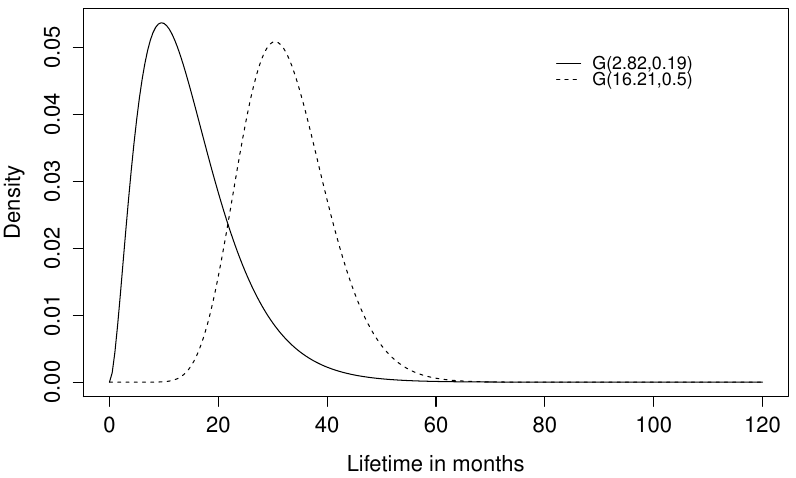
Figure 9. Prior distributions by cluster of experts. Expert 3 is represented by the dotted PDF and the remaining experts are represented by the solid PDF.